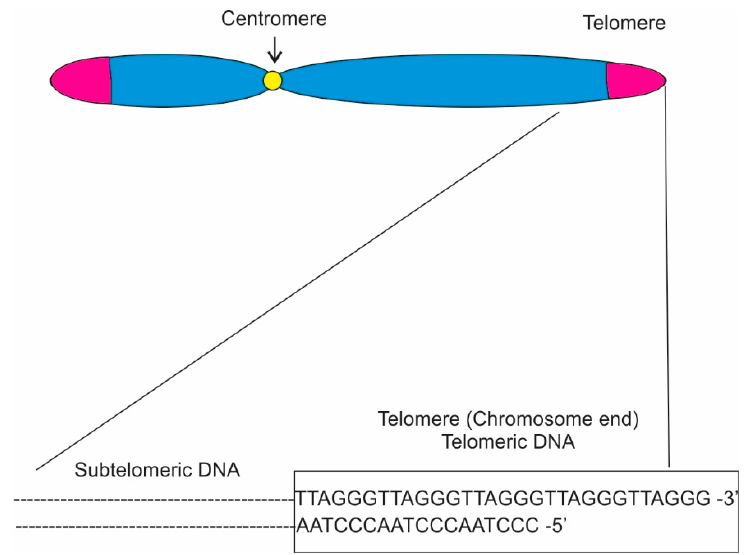
Figure 1. The DNA sequences of a typical chromosomal end structure.